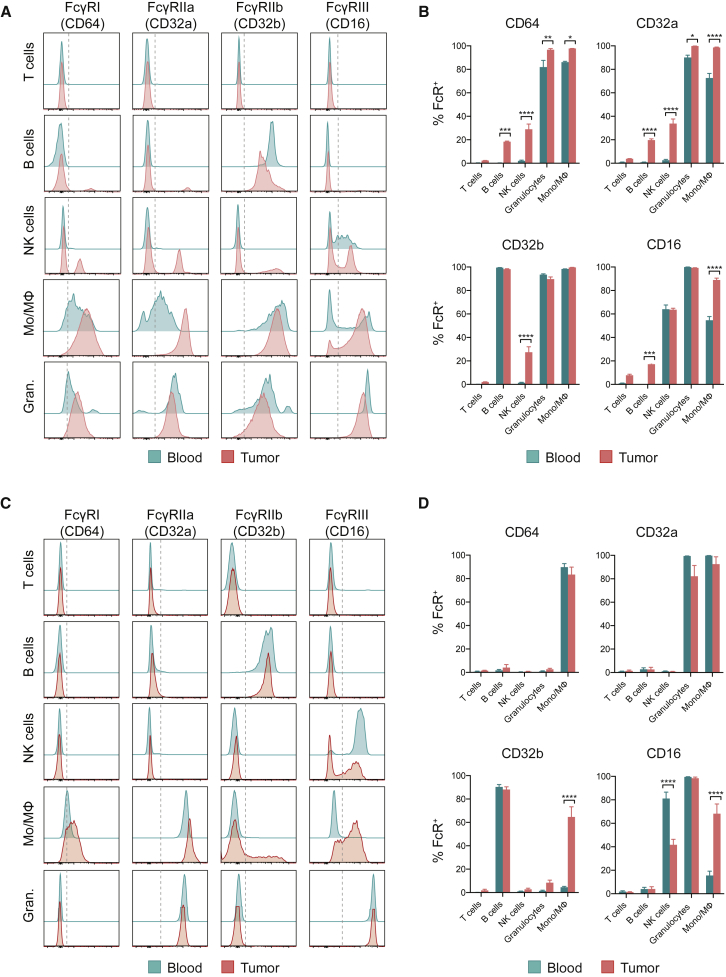
Expression Pattern of FcγRs in hFcγR Mice and Human TumorsThe expression of hFcγRs was analyzed by flow cytometry in leukocyte suspensions obtained from blood and MCA205 tumors in hFcγR mice and from metastatic deposits of human melanoma and paired blood samples.(A) Representative histograms demonstrating FcγR expression on CD3+ T cells, CD19+ B cells, NK1.1+ NK cells, CD11b+NK1.1−Ly6G−CD11clow/− monocyte/macrophages (Mo/MΦ) and CD11b+Ly6G+ granulocytes isolated from hFcγR mice 10 days after s.c. tumor inoculation.(B) Percentage of expression of FcγRs in hFcγR mice from (A) (n = 3). Results are representative of three independent experiments.(C) Representative histograms demonstrating FcγR expression on CD3+CD56− T cells, CD19+CD3− B cells, CD56+CD3− NK cells, CD11b+CD14+HLA-DR+ Mo/Mϕ and CD11b+CD15+CD14− granulocytes isolated from melanoma patient samples.(D) Percentage expression of FcγRs in metastatic deposits of human melanoma from (B) (n = 10). Error bars show ±SEM.∗p < 0.05; ∗∗p < 0.01; ∗∗∗p < 0.001; ∗∗∗∗p < 0.0001. See also Figure S2 and Table S2.